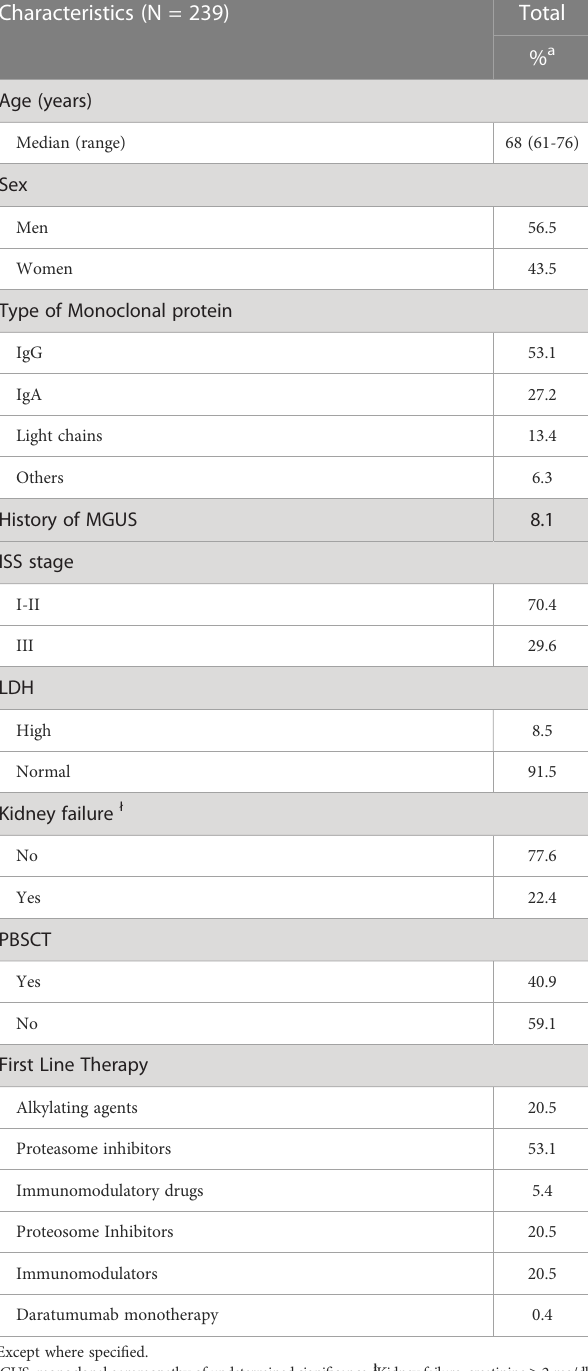
Table 2 shows the genotypes distribution for each analysed polymorphism. The genotype frequencies were comparable to the previously described in Caucasian population.